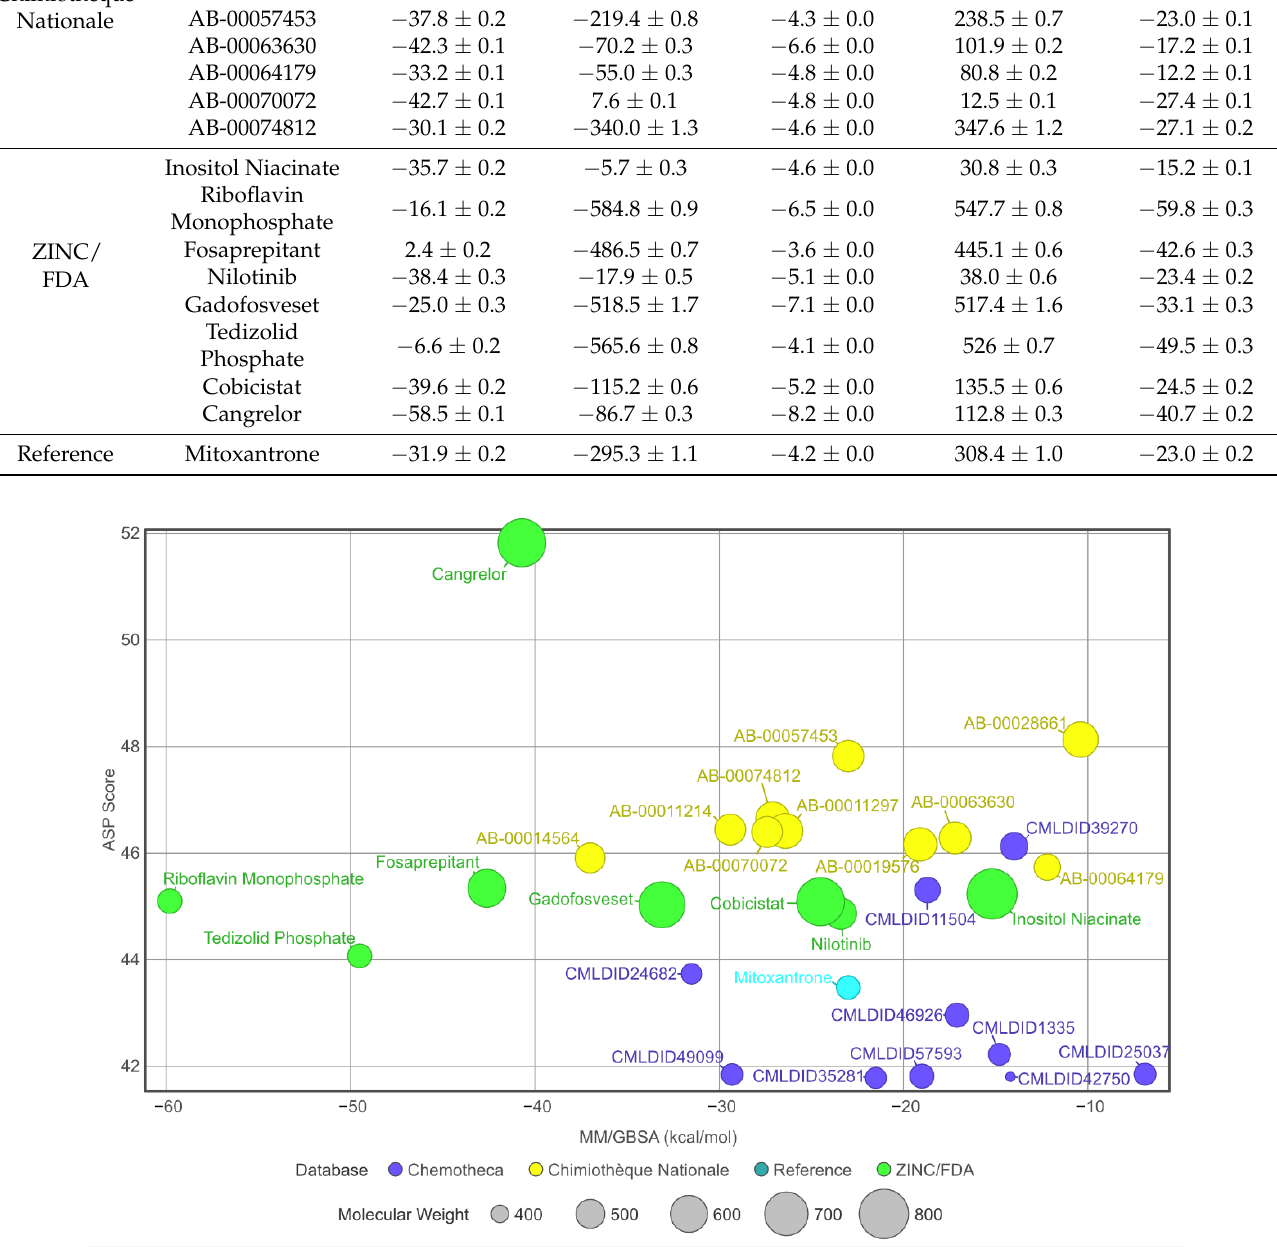
Figure 6. Graph displaying and comparing the results of the free-energy calculation with the results from the virtual screening. The green ligands are the ligands obtained from the ZINC/FDA database, the blue ligands are part of Chemotheca and the yellow ligands are from Chimiothèque Nationale. The reference ligand is in cyan. A total of 15 of 28 ligands performed equal or better than the reference ligand. From these, two were from Chemotheca, six were from Chimiothèque Nationale and seven were from ZINC/FDA. Between these ligands, these MM/GBSA values varied between −23.0 ± 0.1 and −59.8 ± 0.3 kcal/mol, compared to Mitoxantrone’s −23.0 ± 0.2 kcal/mol. The best ligand from Chemotheca was CMLDID24682, with a MM/GBSA value of −31.5 ± 0.1 kcal/mol. The molecule from Chimiothèque Nationale with the best performance was AB- 00014564, with a result of −37.0 ± 0.1 kcal/mol. Lastly, the ligand from ZINC/FDA with the best results was Riboflavin Monophosphate with an MM/GBSA value of −59.8 ± 0.3 kcal/mol. To further analyze the affinity between the best performing ligands and the receptor, the overall binding free energy was decomposed into the contribution of each residue. The residues that had, in general, a bigger contribution are represented in Figure 7. The six top performing ligands were chosen for this analysis, one from Chemotheca (CMLDID24682), two from Chimiothèque Nationale (AB-00014564 and AB-00011214) and three from ZINC/FDA (Table 6). From ZINC/FDA, the molecules chosen were Riboflavin Monophosphate, Tedizolid phosphate and Gadofosveset trisodium.